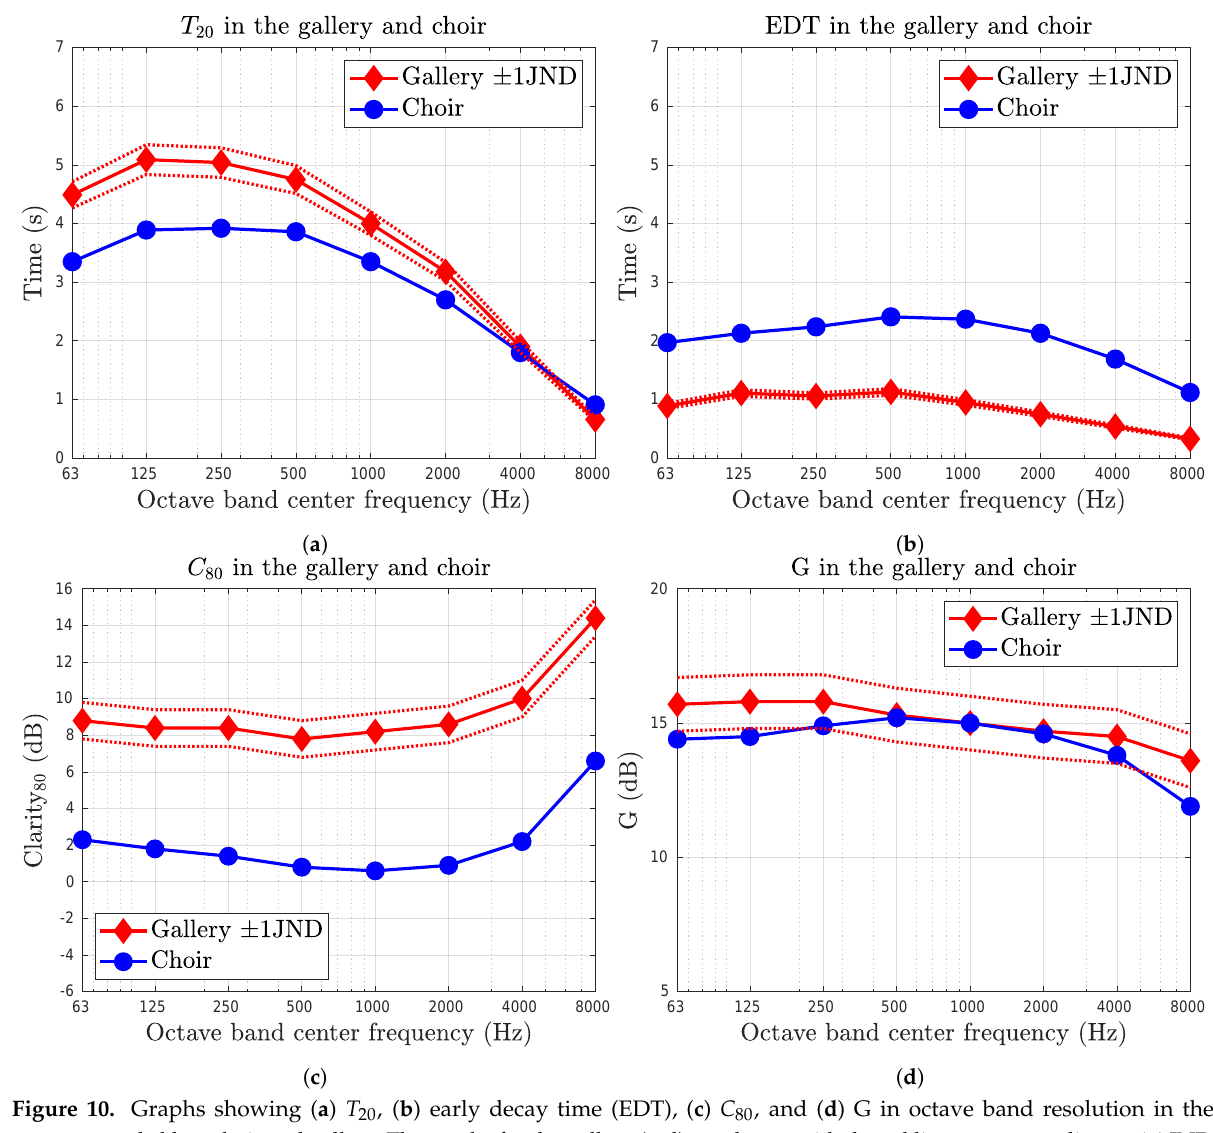
Figure 10. Graphs showing ( a ) T 20 , ( b ) early decay time (EDT), ( c ) C 80 , and ( d ) G in octave band resolution in the reconstructed abbey choir and gallery. The results for the gallery (red) are shown with dotted lines corresponding to ± 1 JND. When the results for the choir (blue) falls within these lines, there is no perceivable difference between the two data